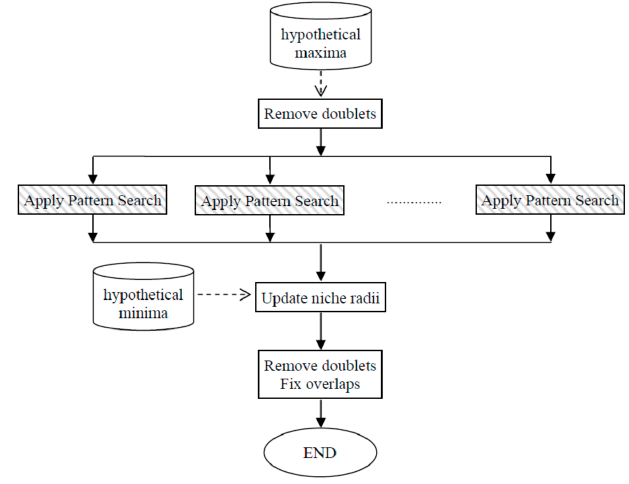
Figure 3. Main steps of the PSALHE-EA’s deterministic section. In the blocks filled with grey lines,